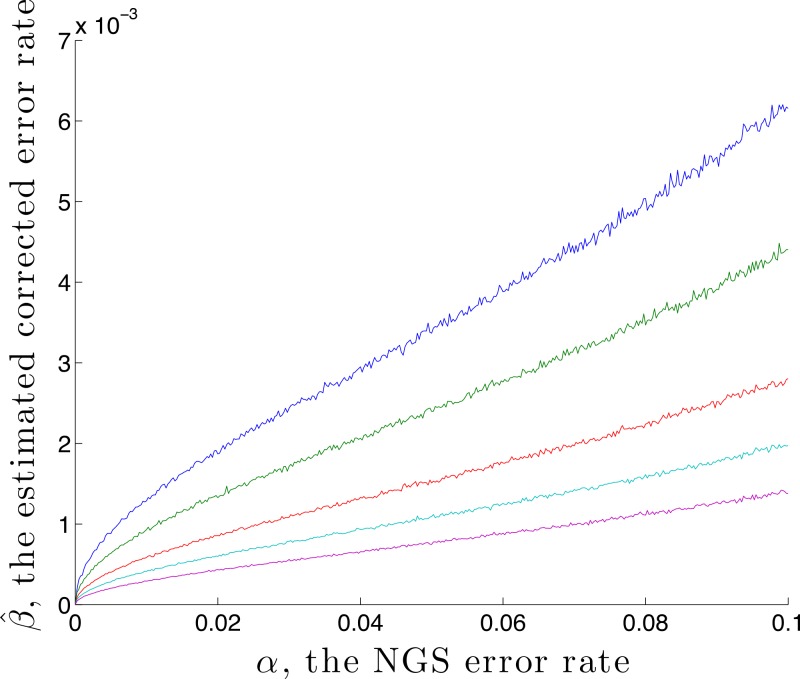
The estimated residual error rate \documentclass[12pt]{minimal}
\usepackage{amsmath}
\usepackage{wasysym}
\usepackage{amsfonts}
\usepackage{amssymb}
\usepackage{amsbsy}
\usepackage{upgreek}
\usepackage{mathrsfs}
\setlength{\oddsidemargin}{-69pt}
\begin{document}
}{}$\hat {\beta }$\end{document}βˆ after correction plotted against the initial error rate α, when the true initial distribution is the degenerate p = (1, 0, 0, 0).The larger the coverage n, the more accurately \documentclass[12pt]{minimal}
\usepackage{amsmath}
\usepackage{wasysym}
\usepackage{amsfonts}
\usepackage{amssymb}
\usepackage{amsbsy}
\usepackage{upgreek}
\usepackage{mathrsfs}
\setlength{\oddsidemargin}{-69pt}
\begin{document}
}{}$\hat {q}$\end{document}qˆ estimates q and so the more dependable the correction, hence the smaller is β. Curves are shown for coverage n of 1,000 (blue), 2,000 (green), 5,000 (red), 10,000 (cyan) and 20,000 (magenta). Each point on the graph is the mean of N = 5,000 replicate trials.